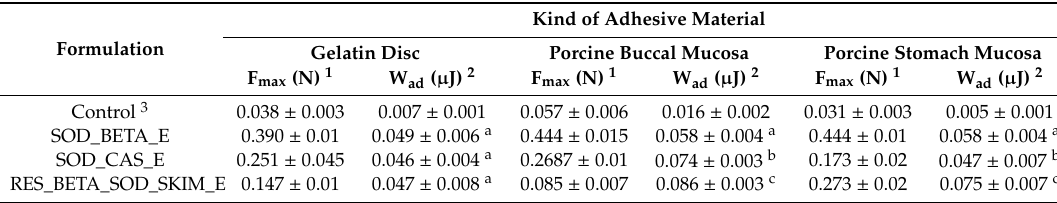
Table 1. Mucoadhesive properties of freeze-dried